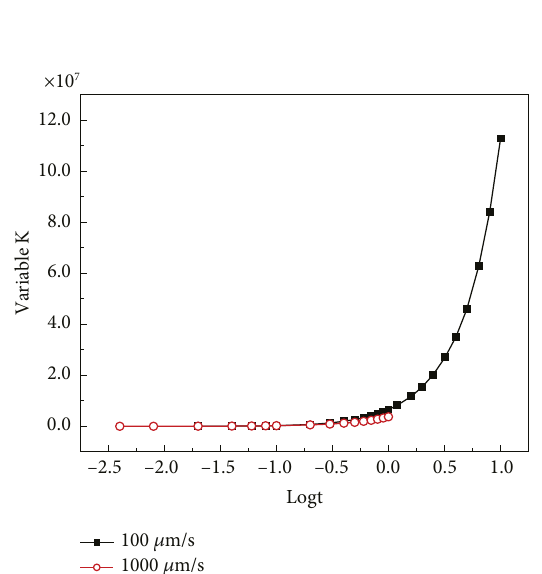
Figure 6: 100 μ m / s data and 1000 μ m / s data